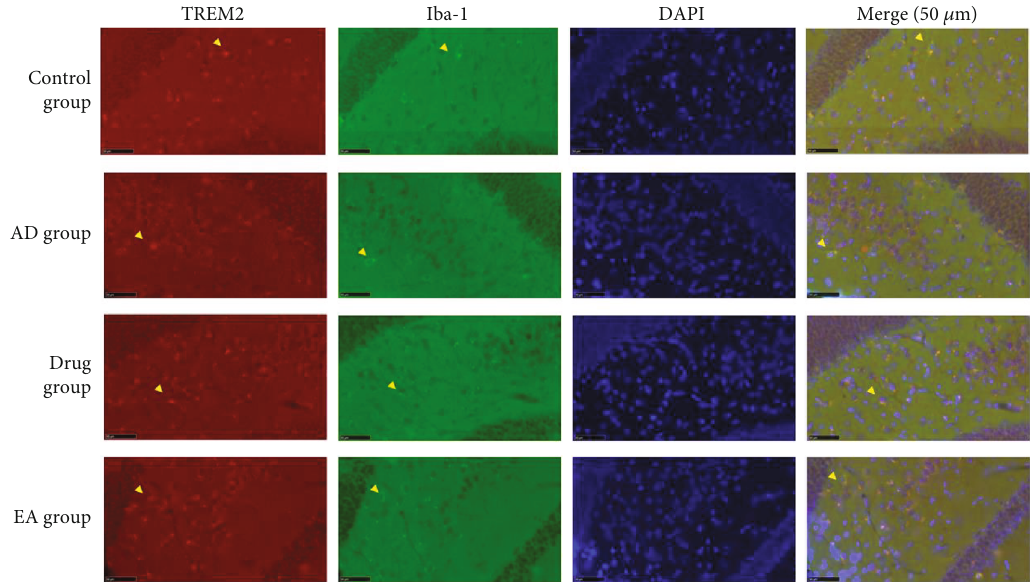
Figure 3: Results of immuno fl uorescence double staining in each group (magni fi cation, × 400; 3 samples of each group). Red light revealing the expression of TREM2 on microglia, green light showing the expression of Iba-1 on microglia, and blue light showing the DNA of the nucleus in the brain. The merge showed the coexpression of TREM2 and Iba-1. The yellow arrows of each group pointed the expression of TREM2 and Iba-1 and the coexpression of TREM2 and Iba-1. We found that both TREM2 and Iba-1 were expressed on the membranes of microglia.